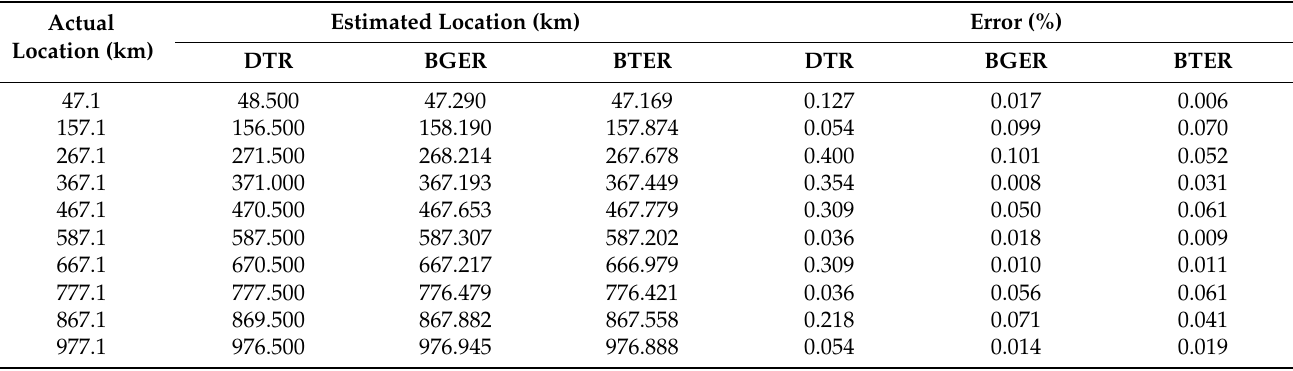
Table 7. Actual and estimated fault location for pole to pole